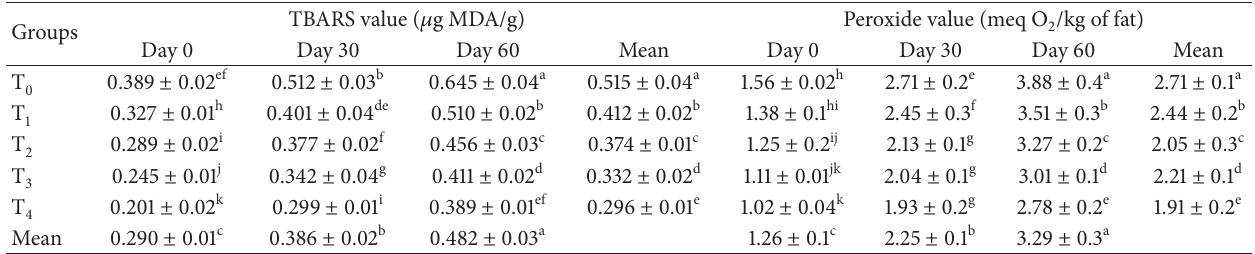
/kg of fat) in thigh chicken meat nuggets. 2